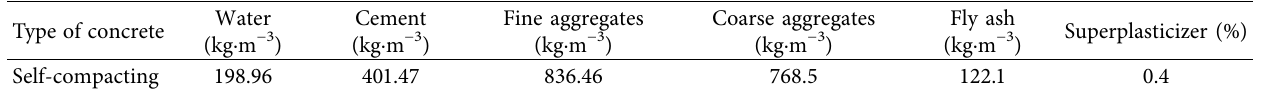
Table 2: Mix proportion of self-compacting concrete.